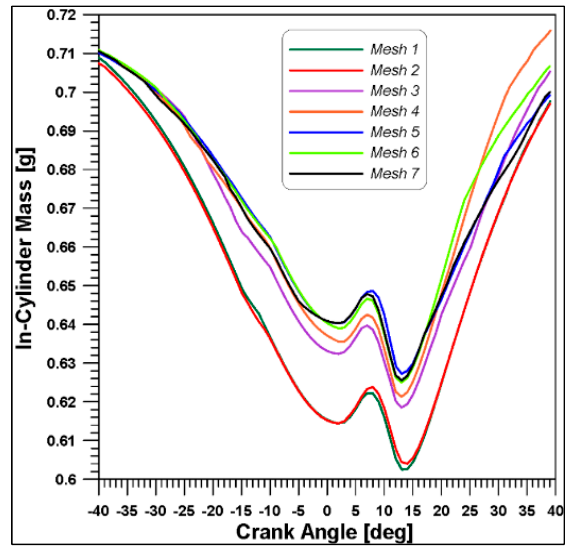
Figure 11. Mass inside the cylinder.